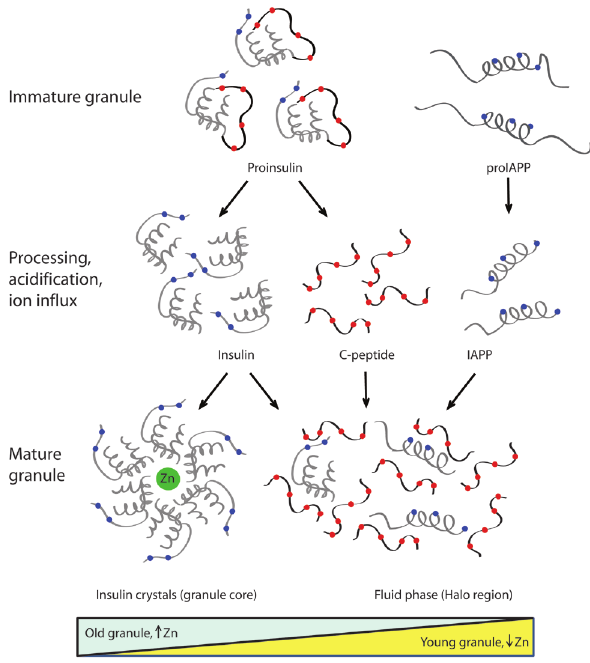
Figure 3 At granular pH, C-peptide binds insulin and IAPP, and prevents their